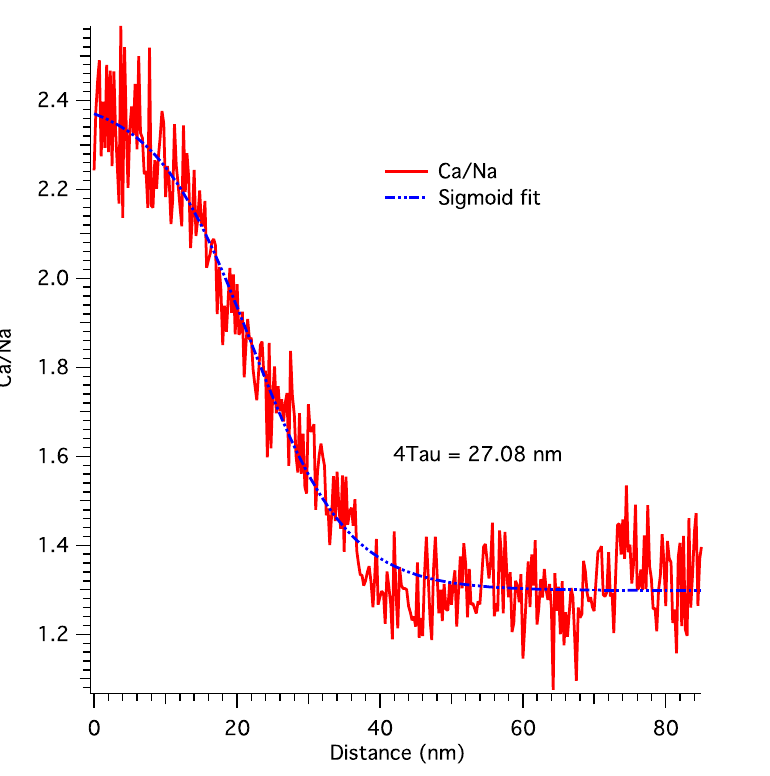
Figure 7. Ratio between Ca and Na atomic counts across the lamellar boundary. The composition changed in a relatively narrow area of less than 30 nm.